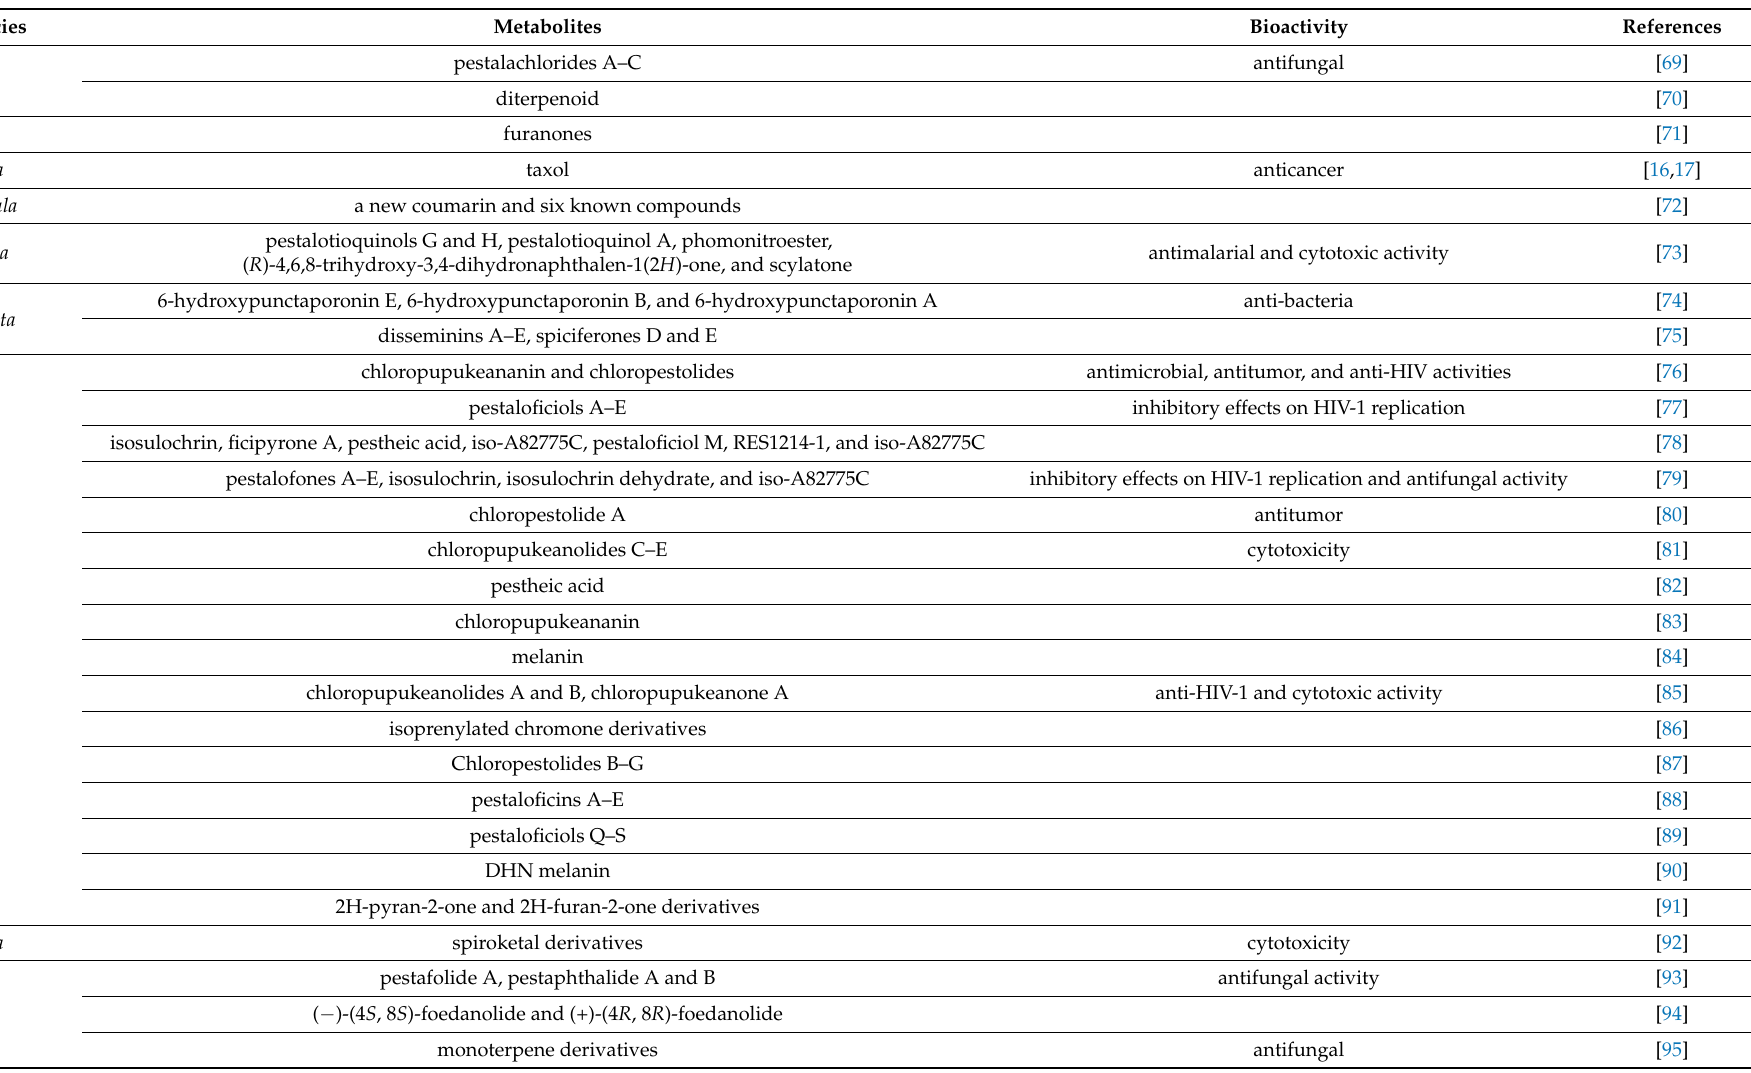
Table 1. Identified metabolites from Pestalotiopsis species and their